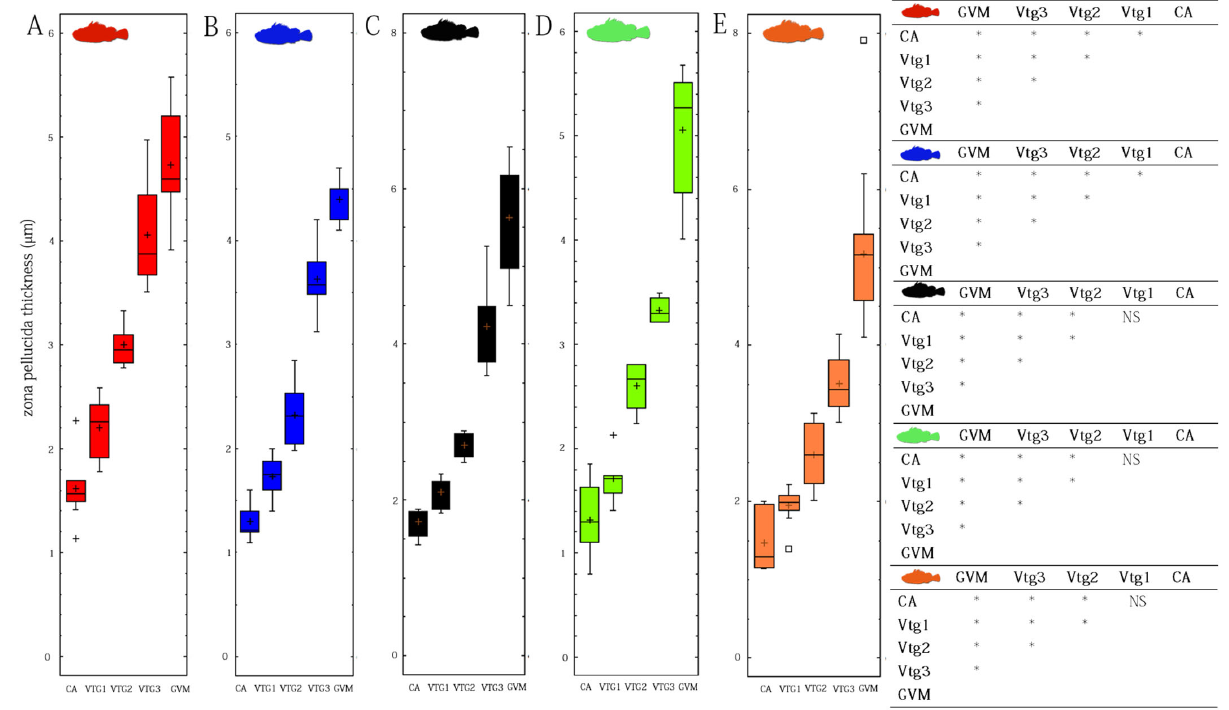
Figure 3. Box- and whisker-plots showing mean value of zona pellucida thickness at different maturity stages. The box represents the 25th and 75th quantile. The points beyond the whiskers are potential outliers. ( A ) Scorpaena scrofa; ( B ) Scorpaena notata ; ( C ) Scorpaena porcus ; ( D ) Scorpaena elongata ; ( E ) Helicolenus dactylopterus . CA, cortical alveoli; GVM, germinal vesicle migration; VTG1, primary vitellogenic; VTG2, secondary vitellogenic; VTG3, tertiary vitellogenic. For each species, a table with significant differences ( p -value < 0.05, *) between maturity stages is provided (NS, not significant differences).